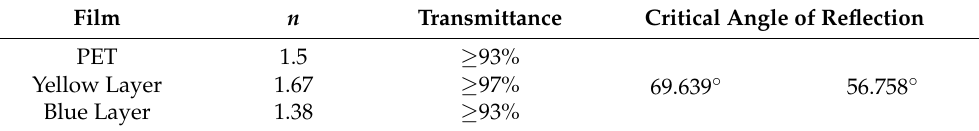
Table 3. Refractive index and structural parameters of each layer of